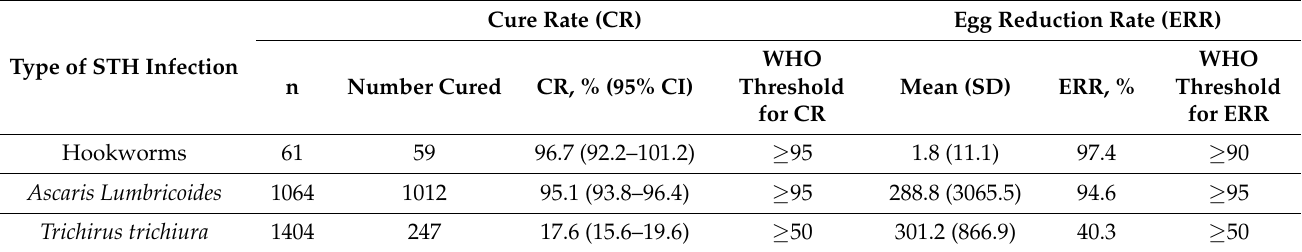
Table 2. Cure and egg reduction rates for the STH species in comparison with the WHO threshold recommended for efficacy